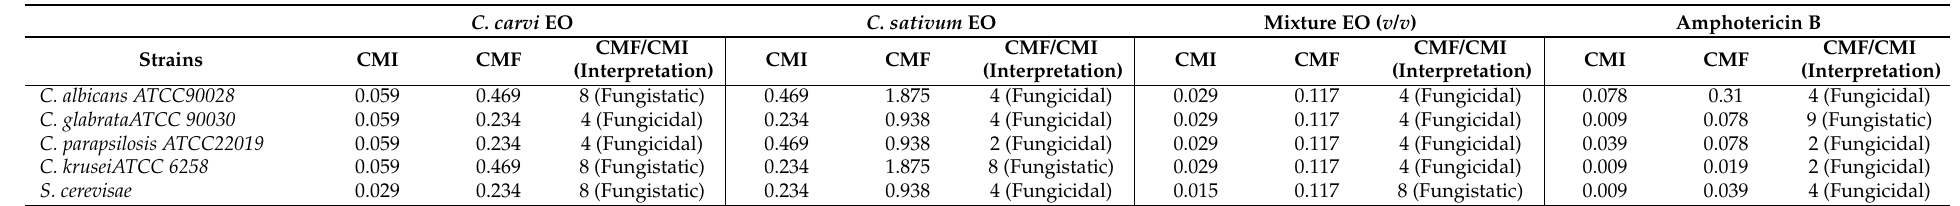
Table 6. Minimal inhibition concentration (MIC), minimal fungicidal concentration (MFC) and ratio MFC/MIC showing antifungal activity for two EOs ( C. carvi and C. sativum ) and their mixture against human pathogenic fungi compared to standard antifungals (Amphotericin B). MIC and MBC values are expressed in